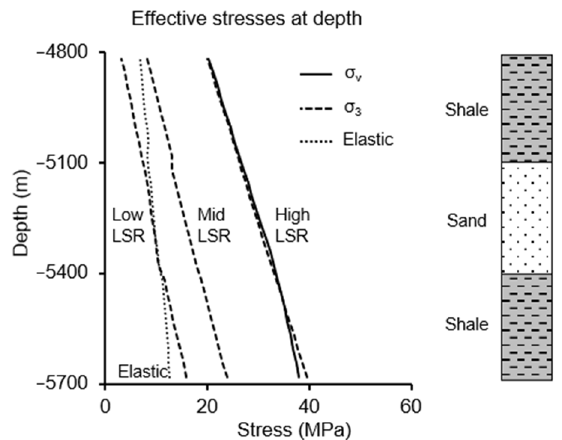
Figure 5. The values of σ v and σ 3 for the three LSR scenarios.